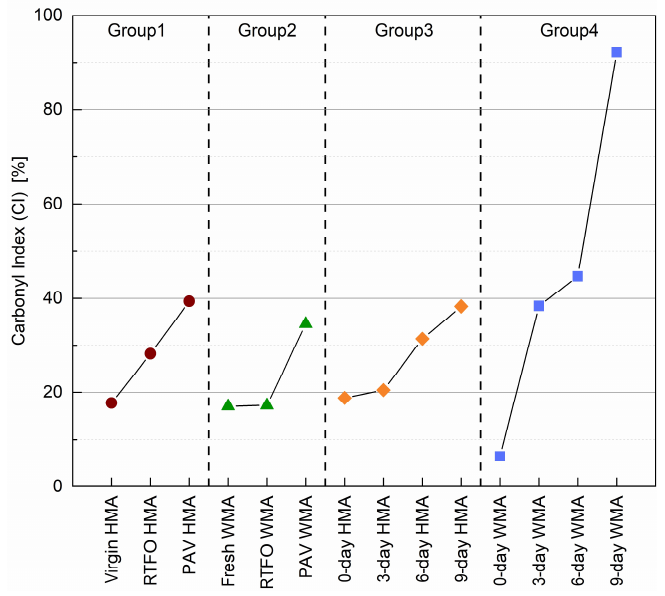
Figure 8. The carbonyl index (CI) for four binder groups before and after ageing.